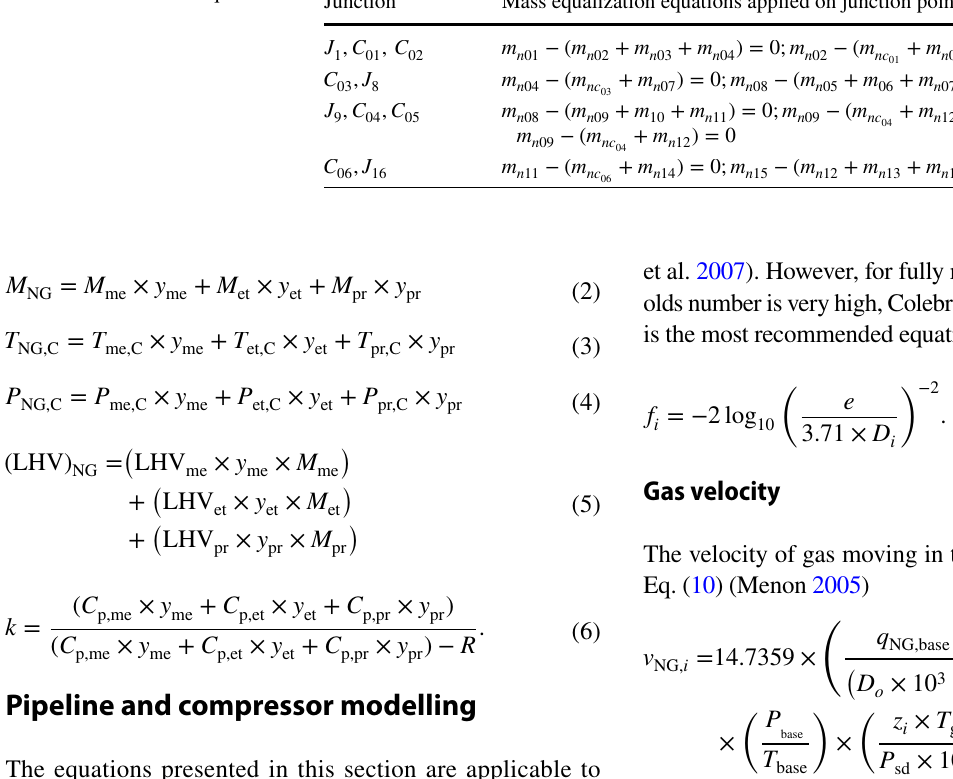
Table 3 Mass balance equations Junction Mass equalization equations applied on junction